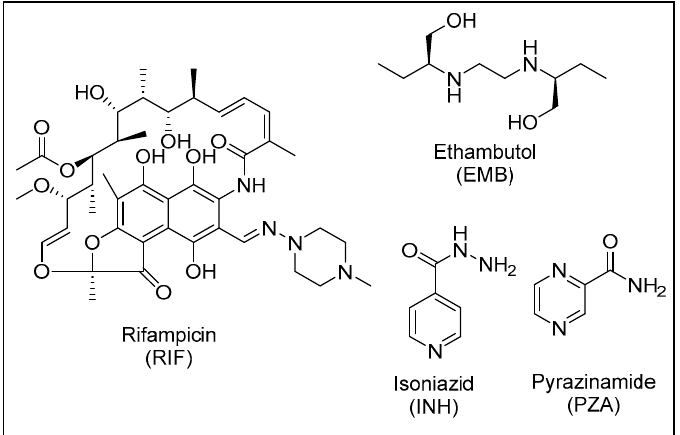
Figure 3 . The four front-line anti-TB drugs. Figure 3. The four front-line anti-TB